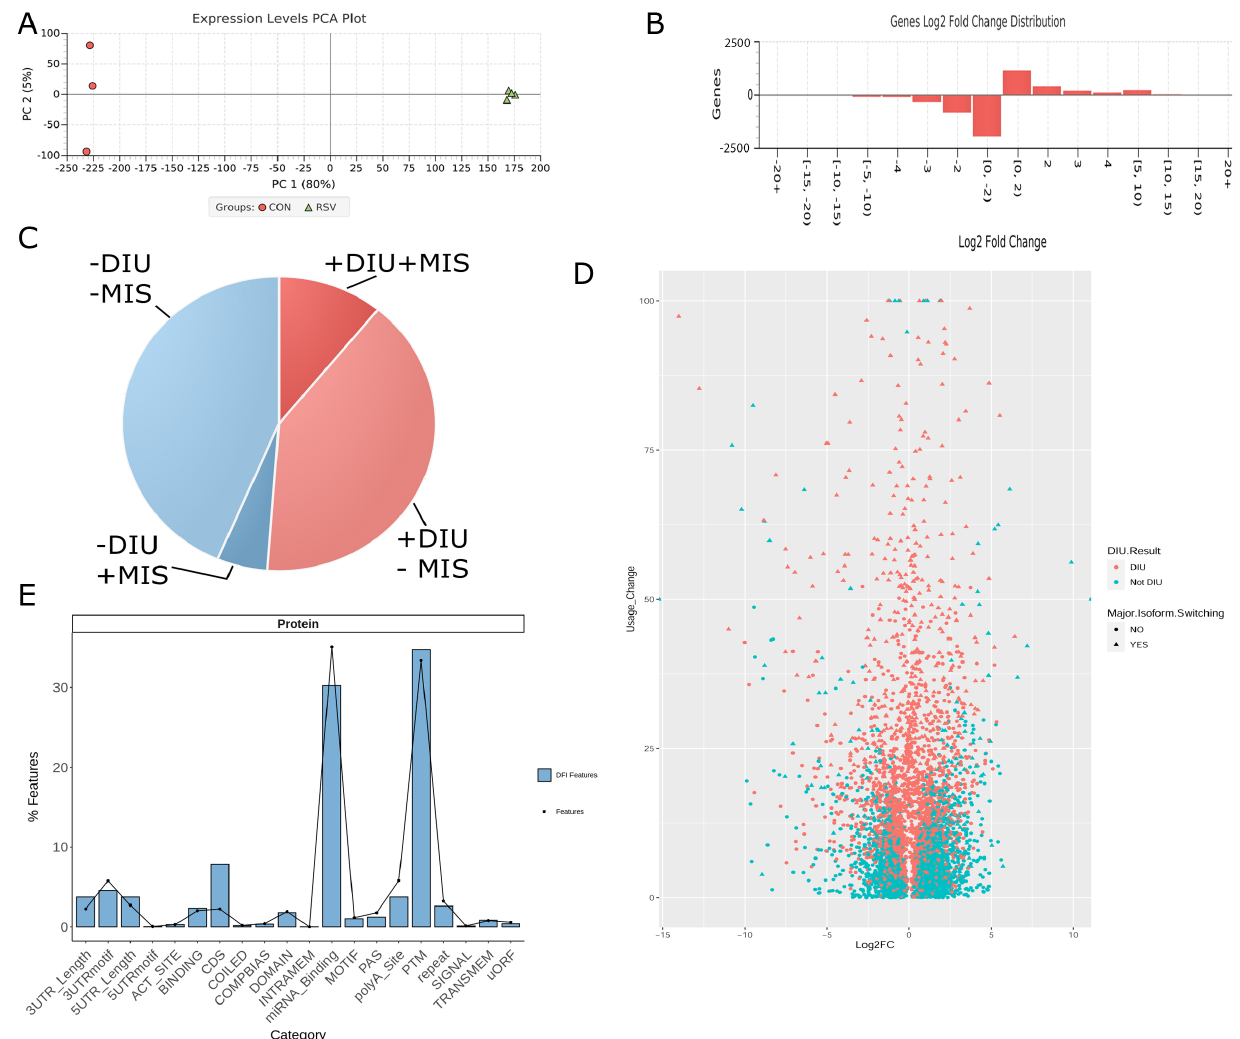
Figure 4. Differential expression analysis. ( A ) Principal component analysis (PCA) of replicate transcriptomes. Note that principal component 1 accounts for >80% of the variance and represents the effect of RSV infection. ( B ) Changes in gene expression for differentially expressed transcripts. ( C ) distribution of differential isoform utilization (DIU) and major isoform shifting (MIS). ( D ) Scatterplot of DIU and MIS in RSV induced differentially expressed transcripts. X axis is log 2 (Fold Change) RSV vs mock infected control. Y axis is Usage Change, an expression of the change in isoforms as a result of RSV infection. ( E ) Functional categories of differential exon splicing in differentially expressed full splice matches (blue boxes) relative to those found in all splice forms (dot symbols). Note that the alternative splicing (AS) exons containing miRNA-binding sites decreased and exons encoding protein domains (coding sequences (CDS)) and exons that are targets for post-translational modifications (PTMs) increased in the RSV-induced